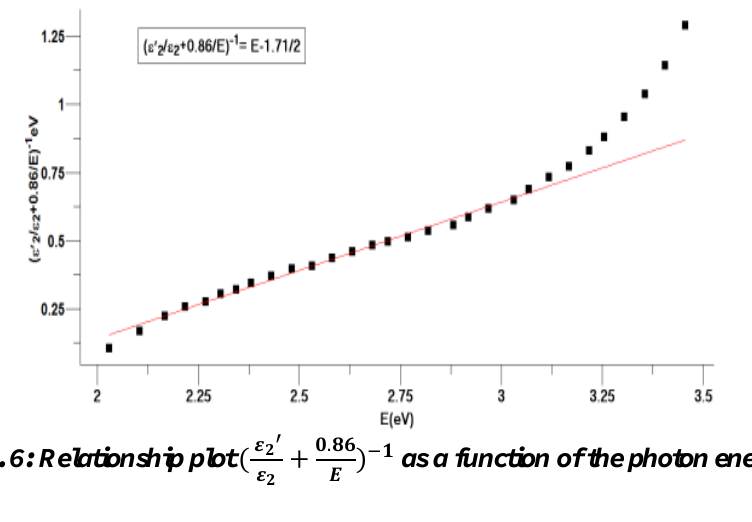
Fig. 6: Relationship plot as a function of the photon